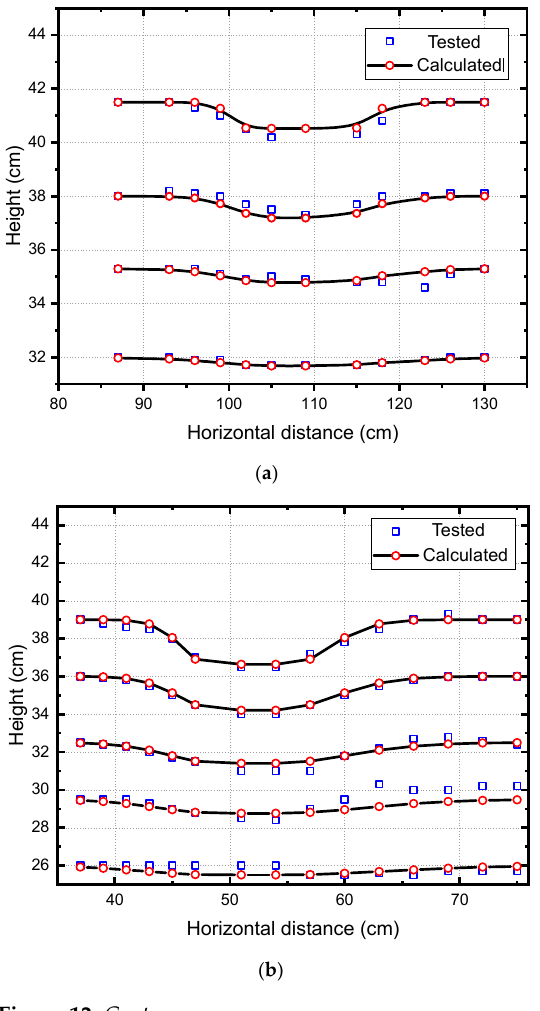
Tested Calculated